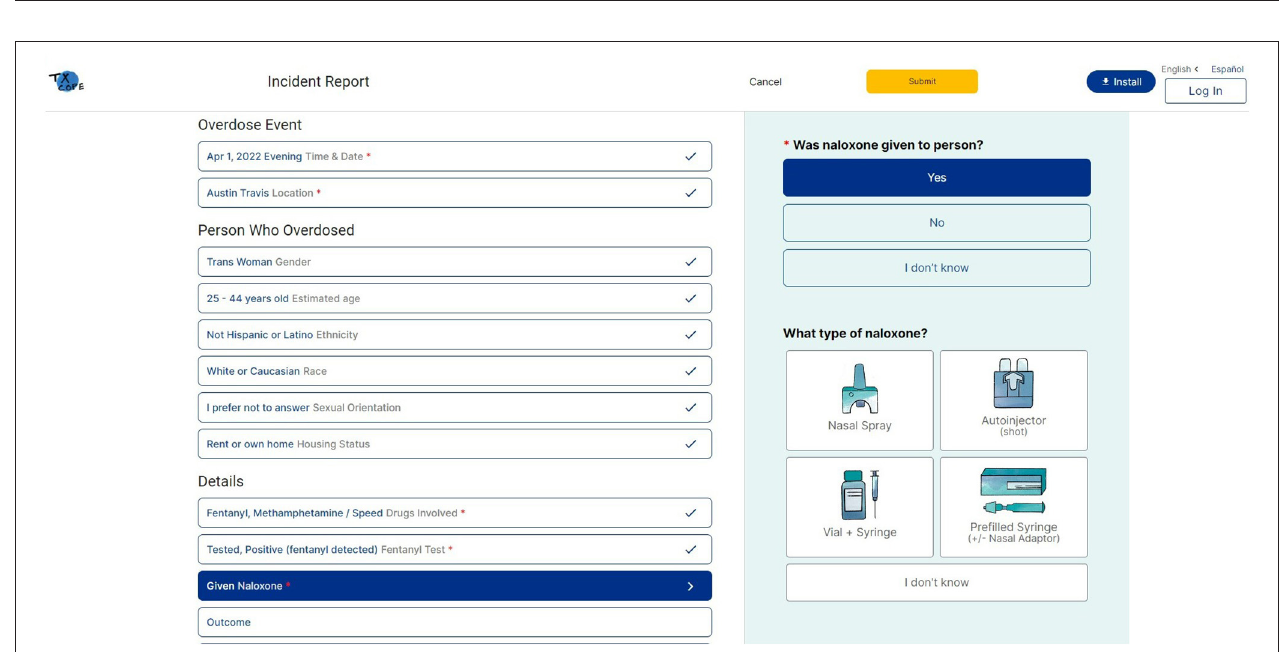
FIGURE 2 | TxCOPE landing page design for harm reduction organizations.